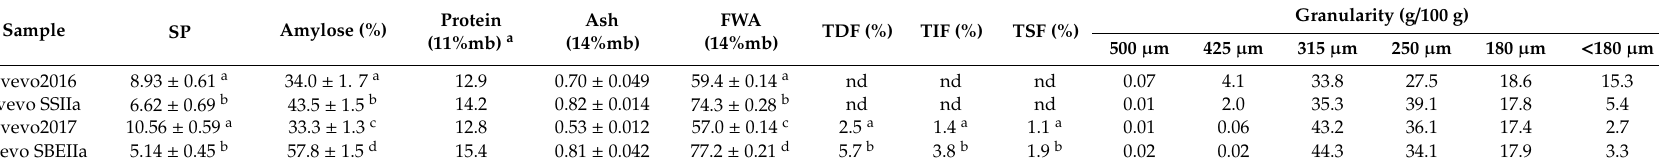
Table 1. Semolina properties of HA and control genotypes.